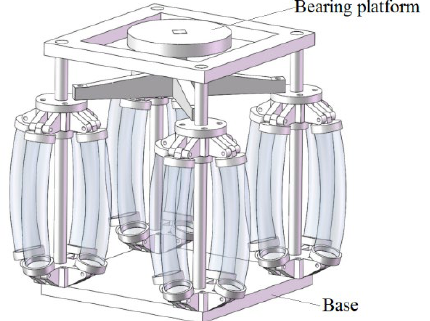
Figure 7. The physical model of vibration isolator.